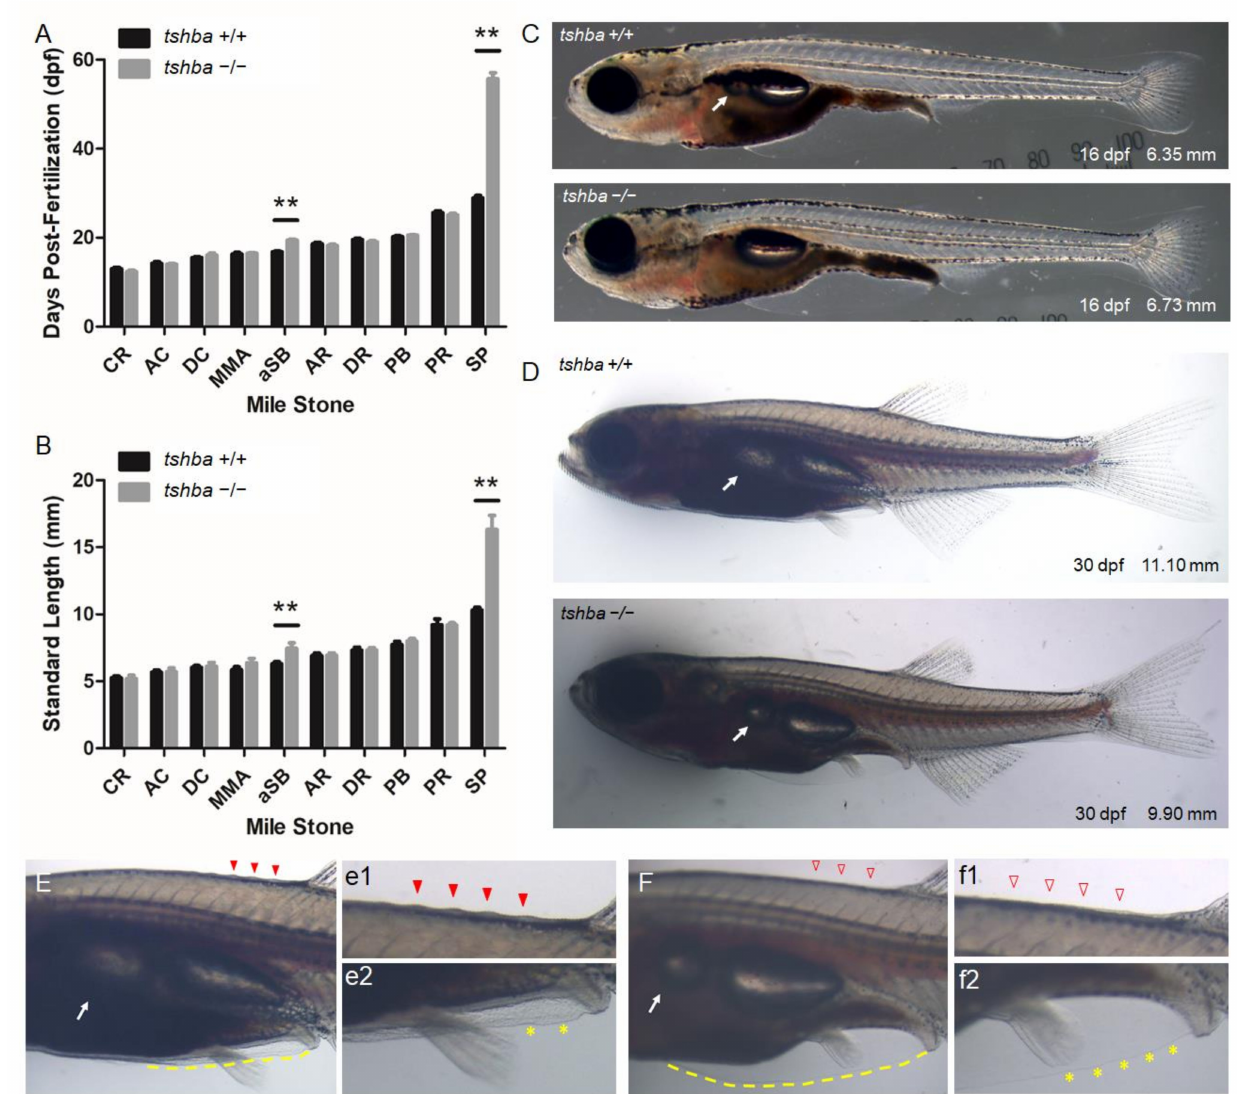
Figure 3. Comparative morphological analyses between wild-type fish and tshba mutant fish prior to the juvenile stage. ( A ) Comparative morphological features and their relationships with age of fish between tshba mutant zebrafish and their wild-type siblings. ( B ) Comparative morphological features observed and their relationships with fish size between tshba mutant zebrafish and wild-type siblings. The x-axes show developmental milestones describing early larval stages (left) toward late larval stages (right). Measurements were taken of wild-type fish (n = 11) and tshba mutants (n = 10). ( C ) Morphological features of wild-type and tshba mutants at 16 dpf. Arrows indicate the appearance of inflated anterior swim bladders. ( D ) Morphological features of wild-type and tshba mutants at 30 dpf. Arrows indicate the appearance of inflated aSBs. ( E ) Higher magnification views of wild-type fish (30 dpf) showing an inflated aSB (arrows), anterior squamation (SA; details in ( e1 ), red arrowhead), minor fin fold (dotted yellow line, details in ( e2 ) labelled with yellow asterisks), vent, and anal fin. ( F ) Higher magnification views of tshba mutant fish (30 dpf) showing a smaller inflated aSB (arrows), SA (details in ( f1 ), red arrowhead), minor fin fold (dotted yellow line, details in ( f2 ) labeled with yellow asterisks), vent, and anal fin. Stage abbreviations: CR, caudal fin ray appearance; AC, anal fin condensation; DC, dorsal fin condensation; MMA, metamorphic melanophore appearance; aSB, inflation of anterior swim bladder lobe; AR, anal fin ray appearance; DR, dorsal fin ray appearance; PB, pelvic fin bud appearance; PR, pelvic fin ray appearance; SP, posterior squamation; SA, anterior squamation.** p <